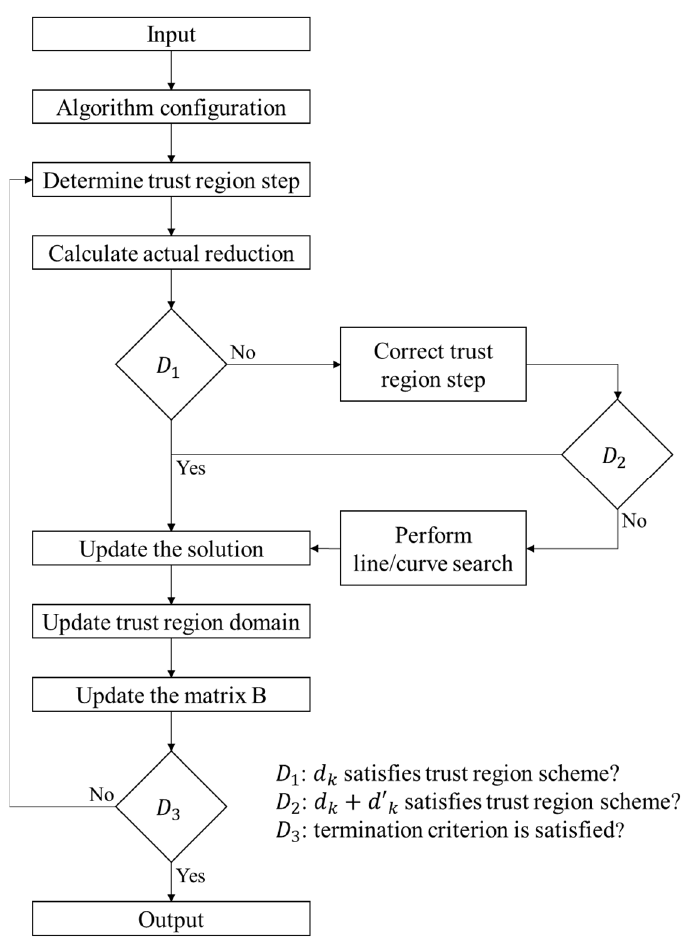
Figure 8. Flowchart of the hybrid trust region (HTR) algorithm.